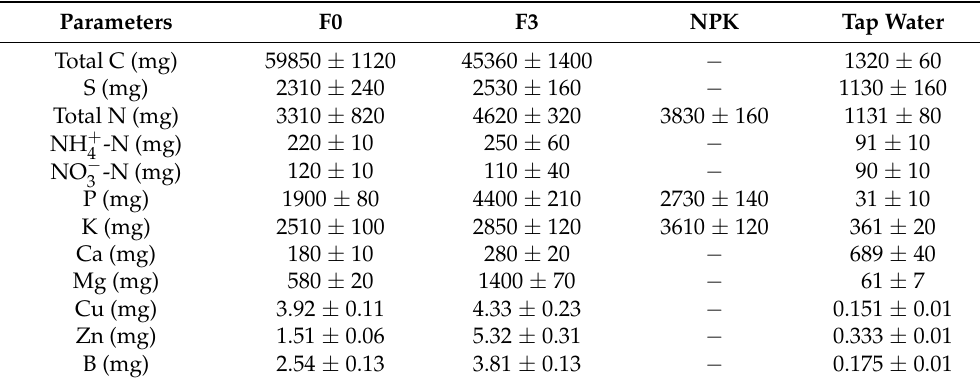
Table 3. Mean ( ± SE) total nutrients added by the different treatments over the three planting cycles (90 days in